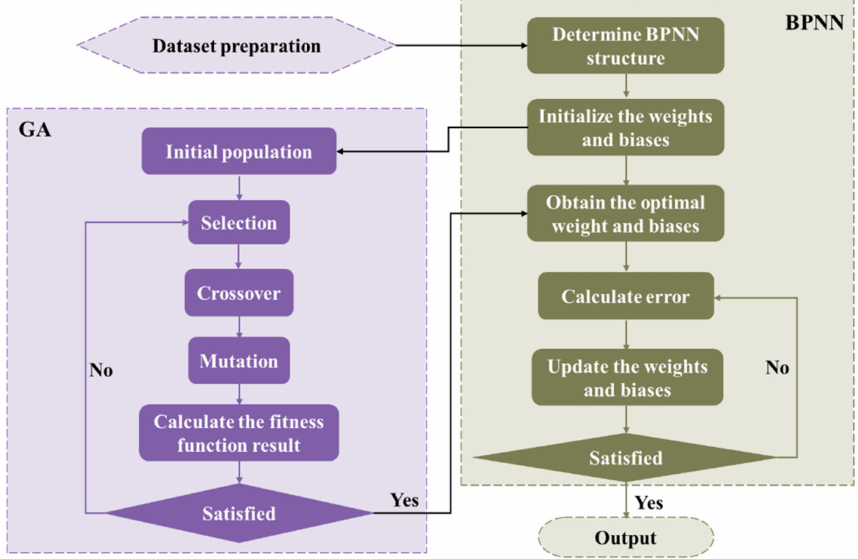
Figure 2. The working flow chart of the GA-BPNN